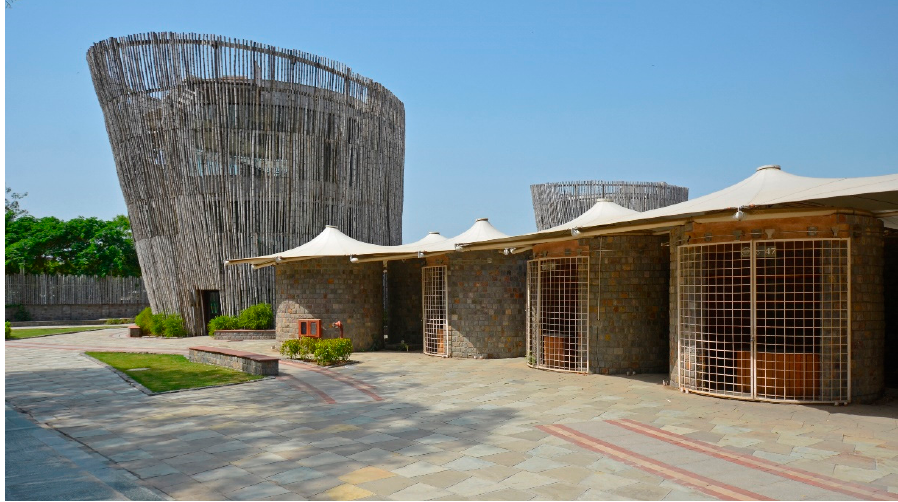
Figure 30. Dilli Haat Janakpuri, New Delhi (2014) by Archohm Consults (Photo: author).